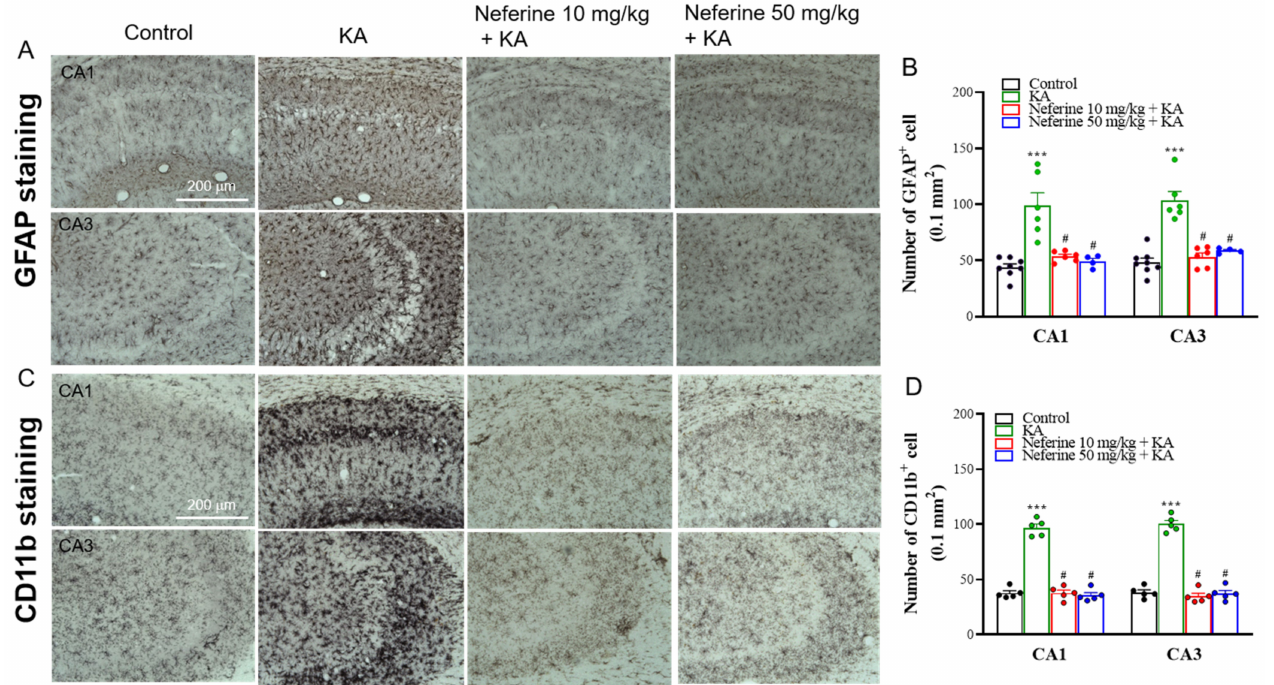
Figure 5. Results of GFAP and CD11b staining in the rat hippocampus. ( A , C ) Representative images in the different groups and ( B , D ) quantitative data for the number of GFAP- or CD11b-positive hippocampal neurons ( n = 4–8 rats/group). Neferine decreased the numbers of GFAP- or CD11b- positive hippocampal neurons in the CA1 and CA3 areas (one-way ANOVA). *** p < 0.05 vs. control group. # p < 0.05 vs. KA-treated